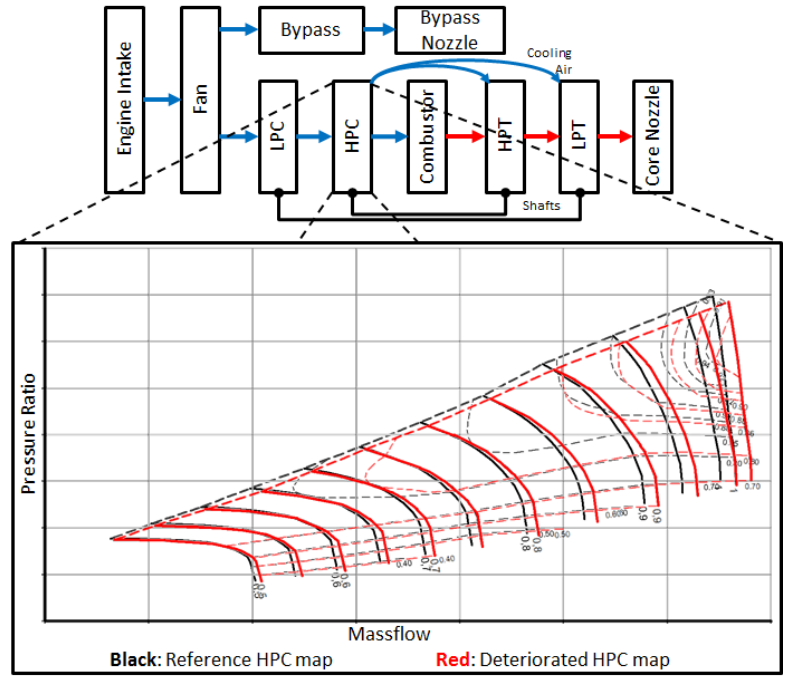
Figure 5. Scheme of a modular performance synthesis model with modified HPC